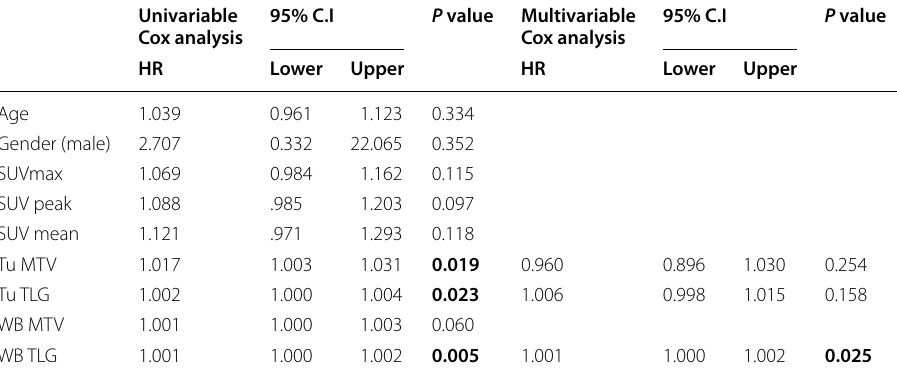
In bold are highlighted the p values that reached statistical